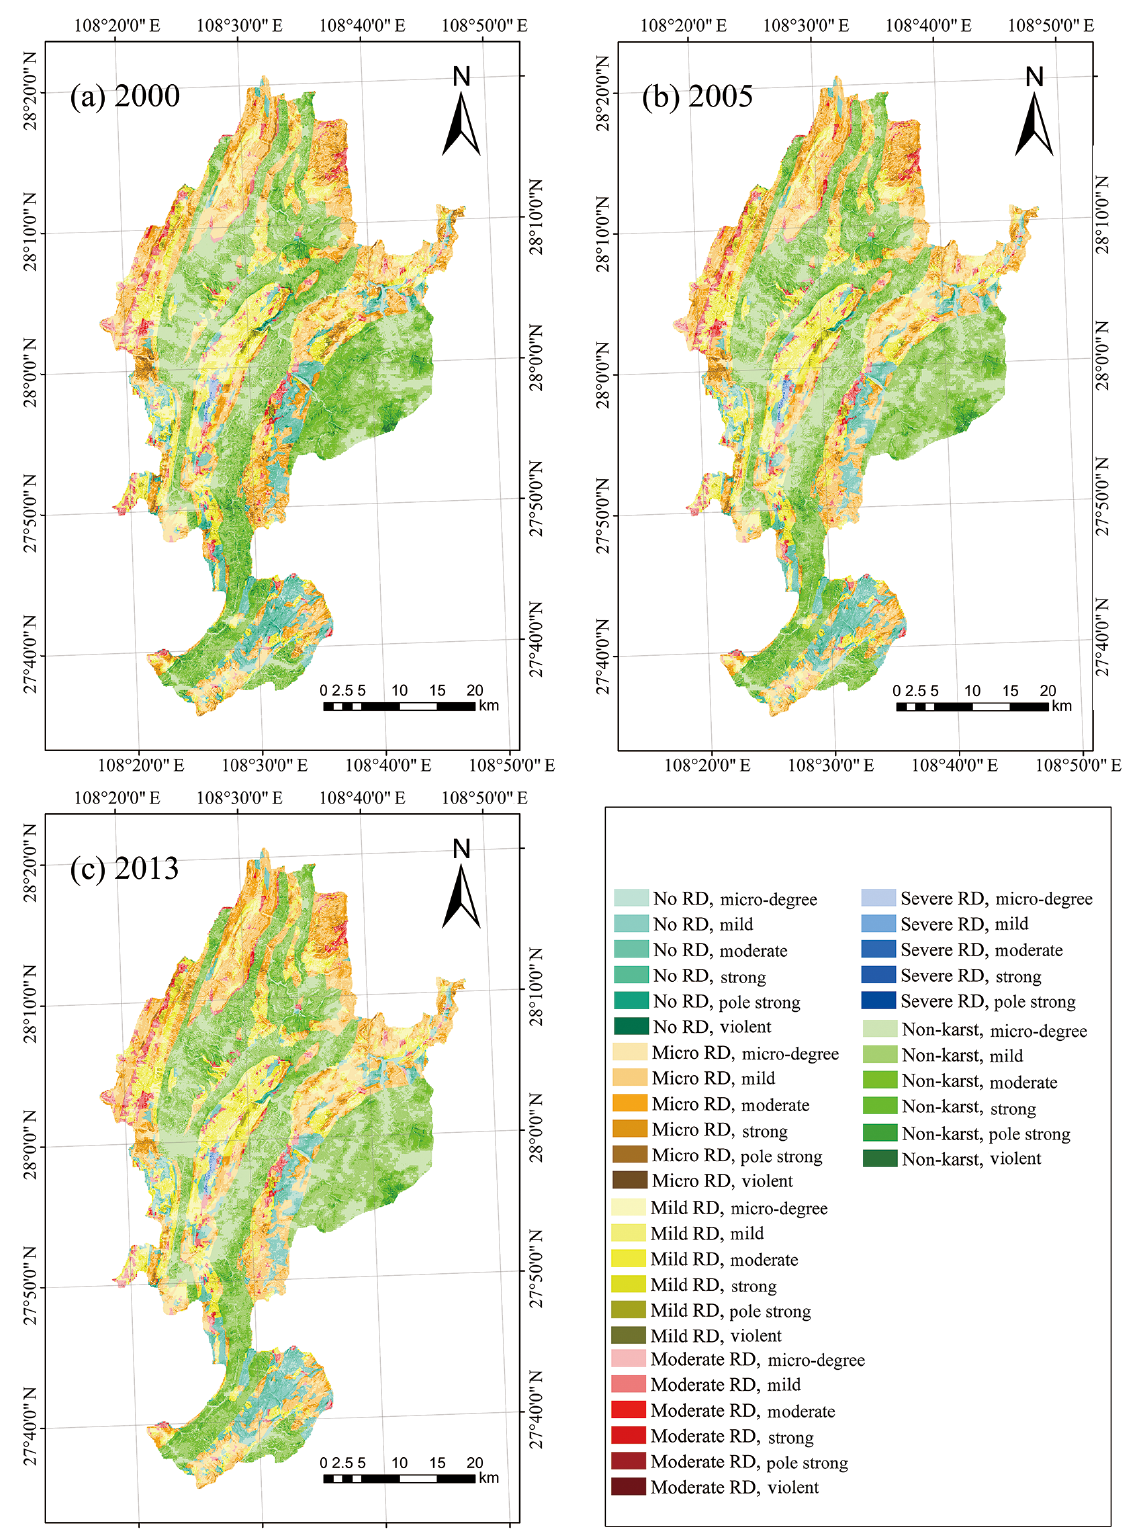
Figure 8. Spatial distribution of soil erosion on different rocky desertification